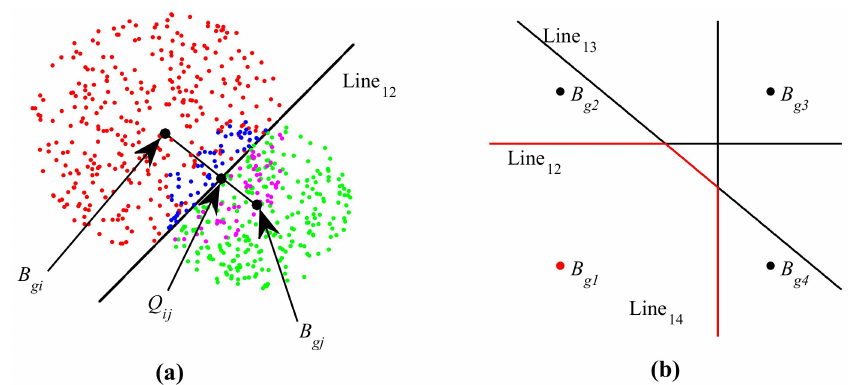
Figure 2. Particle center supported plane. (a) Calculation of a boundary. (b) Discriminant process.